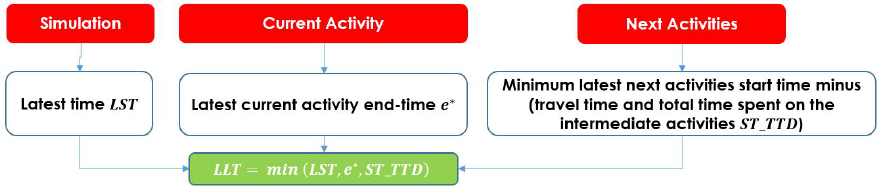
Figure 13. Local latest time: LLT is equals the minimum of (1) LST from simulation, (2) e ∗ of the current activity, and (3) ST _ TTD the latest possible time to complete the activity-plan (next activities), by satisfying the duration and end-time constraints (spending the typical duration in each activity and finishing each activity before the